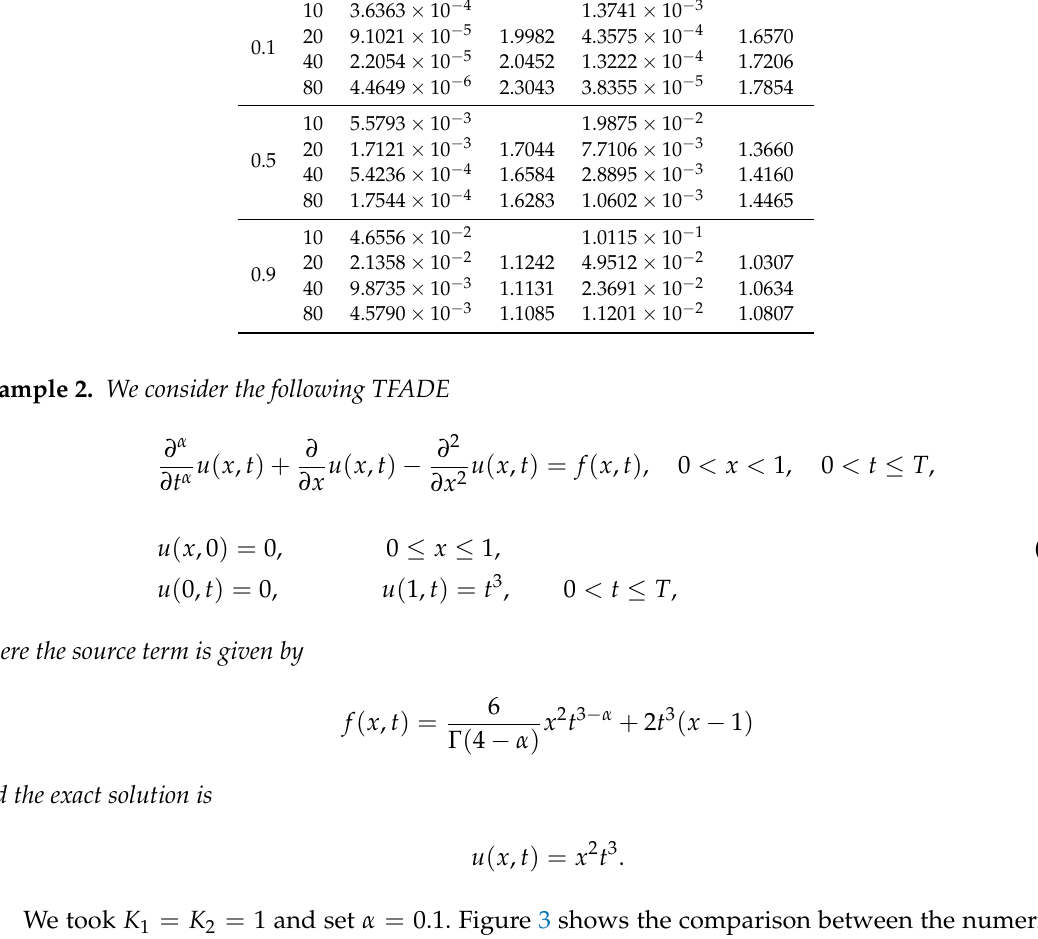
and ¯ U n respectively, j j